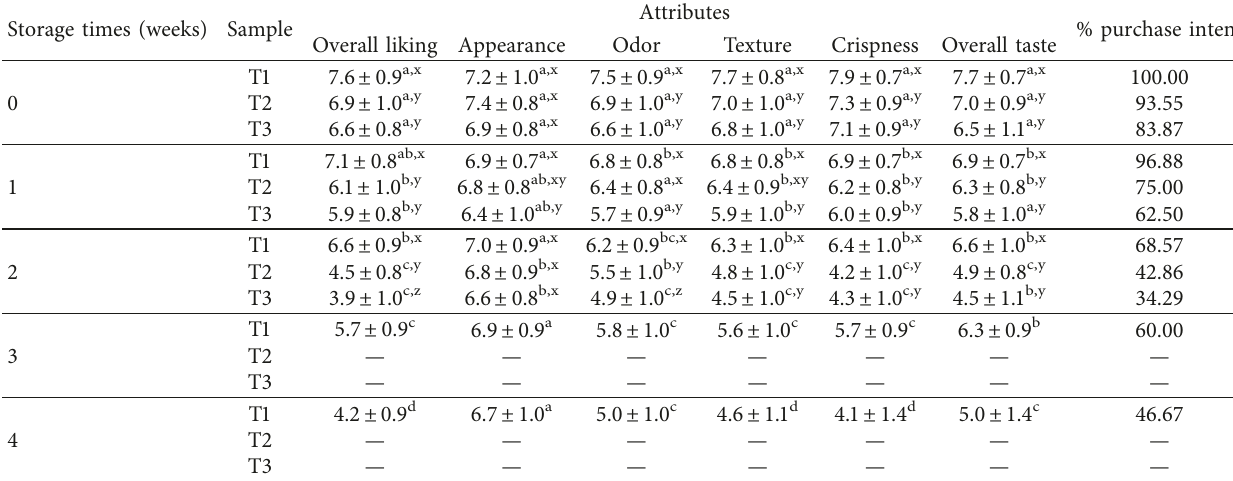
Table 4: Sensory acceptance test of Kaeb Moo attributes using a 9-point hedonic scale and % purchase intent. Storage times (weeks) Sample